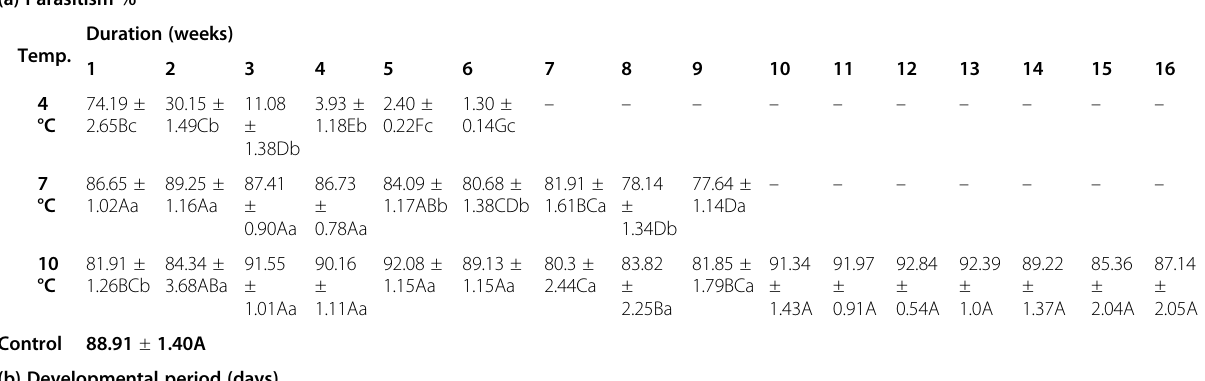
Table 1 Percentages of parasitism and developmental period of Trichogrammatoidea bactrae in parental generation during storage of parasitoid larvae at different low temperatures (a) Parasitism